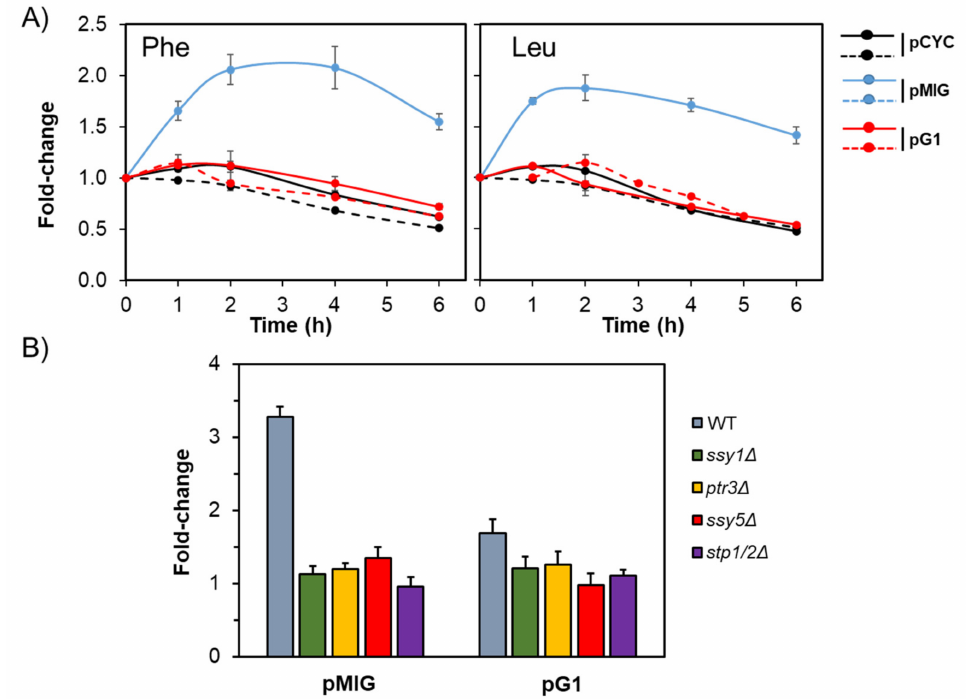
Figure 4. The Stp1/2 site in the ENA1 promoter responds to amino acids. ( A ) Strain CEN.PK113-5D was transformed with the indicated constructs and was grown in a minimal medium with Pro as the only nitrogen source, as described in Materials and Methods. Then, 1.5 mM Leu or Phe was added (solid lines), and growth continued. Samples were taken at the indicated periods of time and processed for flow cytometry. ( B ) Amino acid-induced response of the Stp1/2 site is abolished in mutants in the SPS pathway. The indicated strains (23344c background) carrying the pMIG or pG1 constructs were switched from Pro to Phe-containing medium, and samples were processed for flow cytometry after 2 h. In all cases, the ratio of RFU values of the induced vs non-induced cultures was calculated and is expressed as the mean ± SEM from six independent